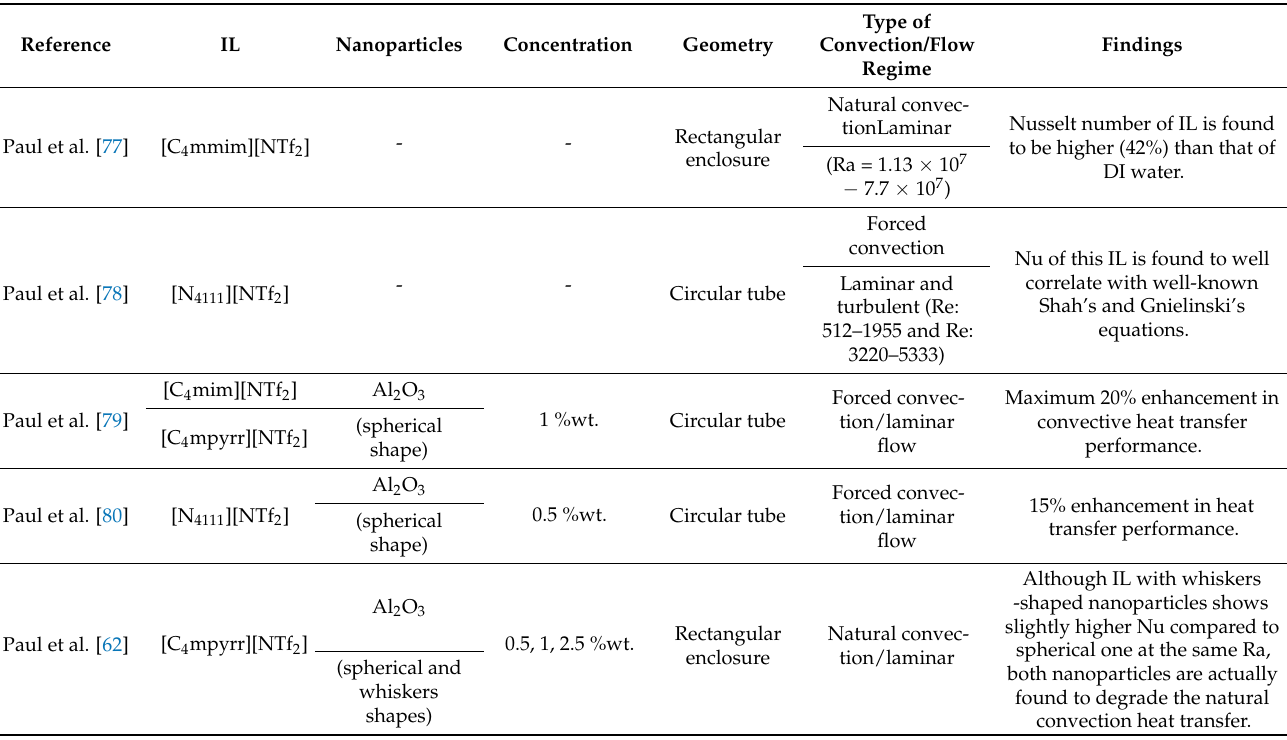
Table 7. Summary of experimental studies on convective heat transfer of ILs and their nanofluids from the literature.